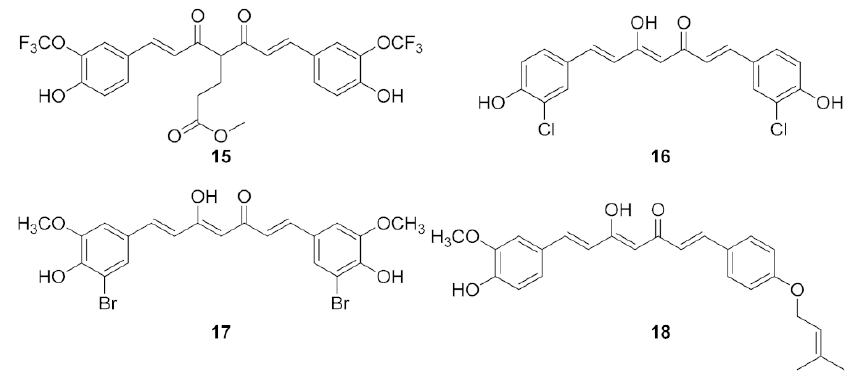
Figure 7. Structures of compounds with halogenated or prenylated aromatic